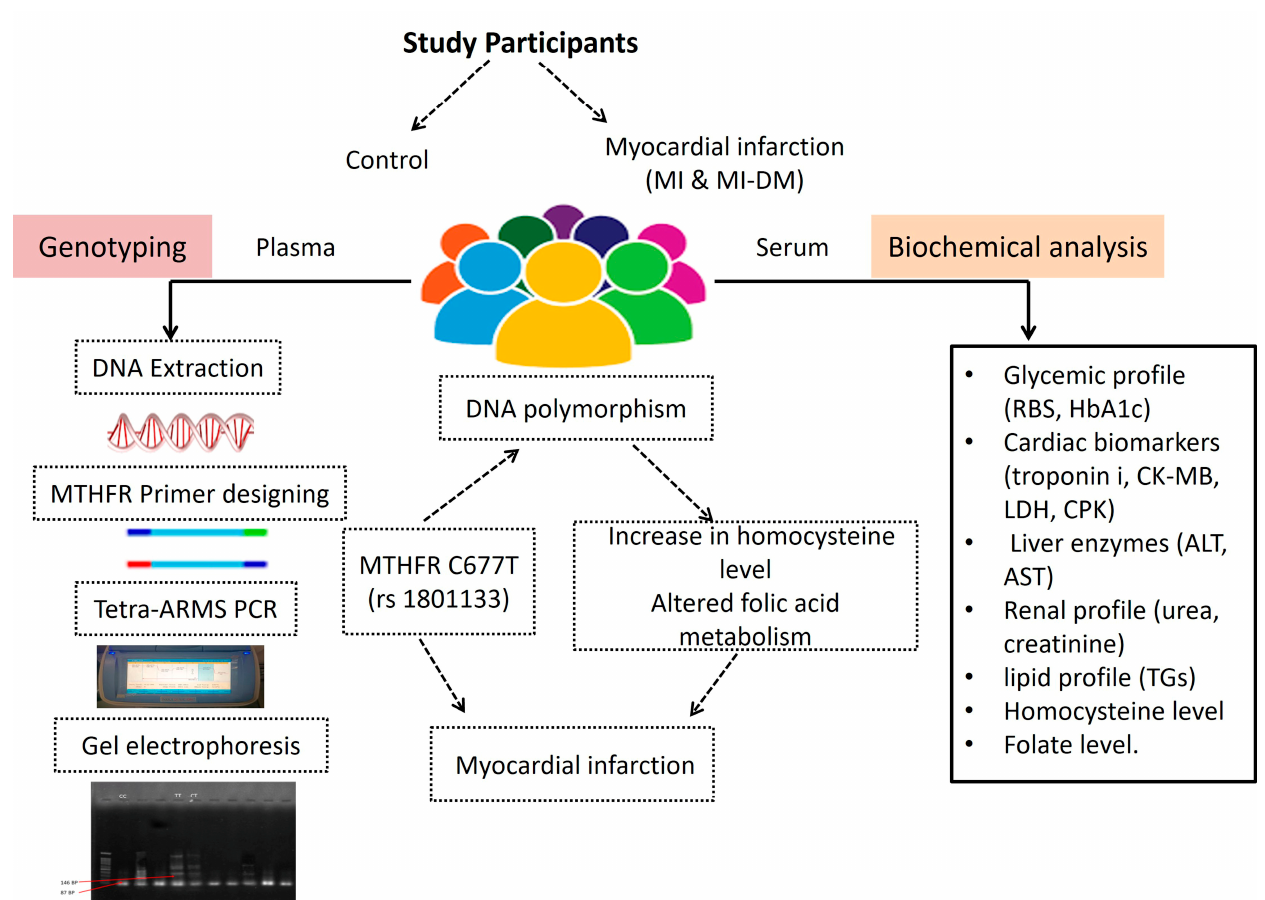
Figure 3. Genotype and biochemical analysis of MTHFR C677T